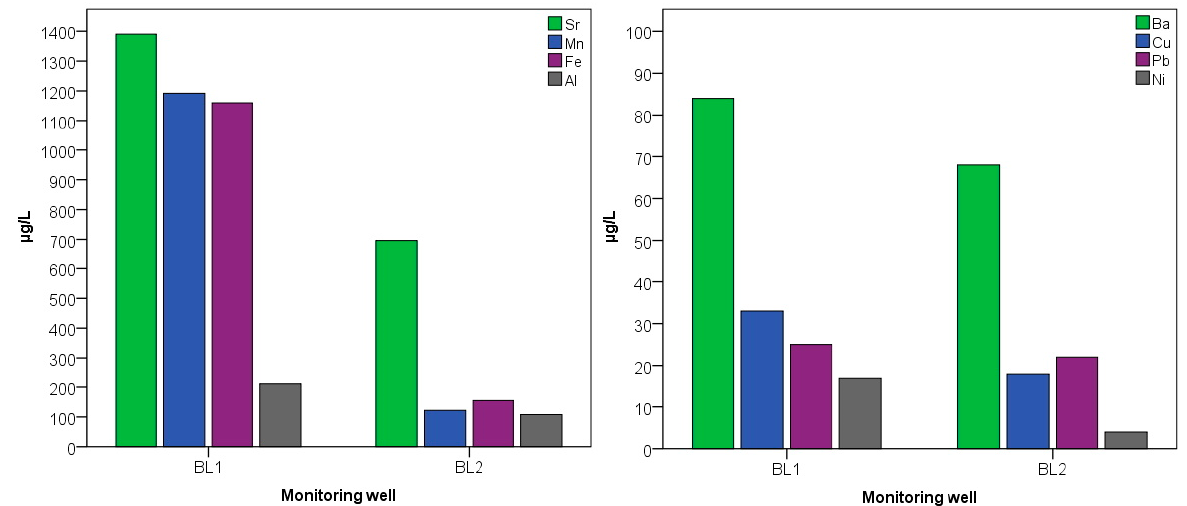
Figure 9. Microelement values of water samples from BL1 and BL2 monitoring wells in the summer of 2020.